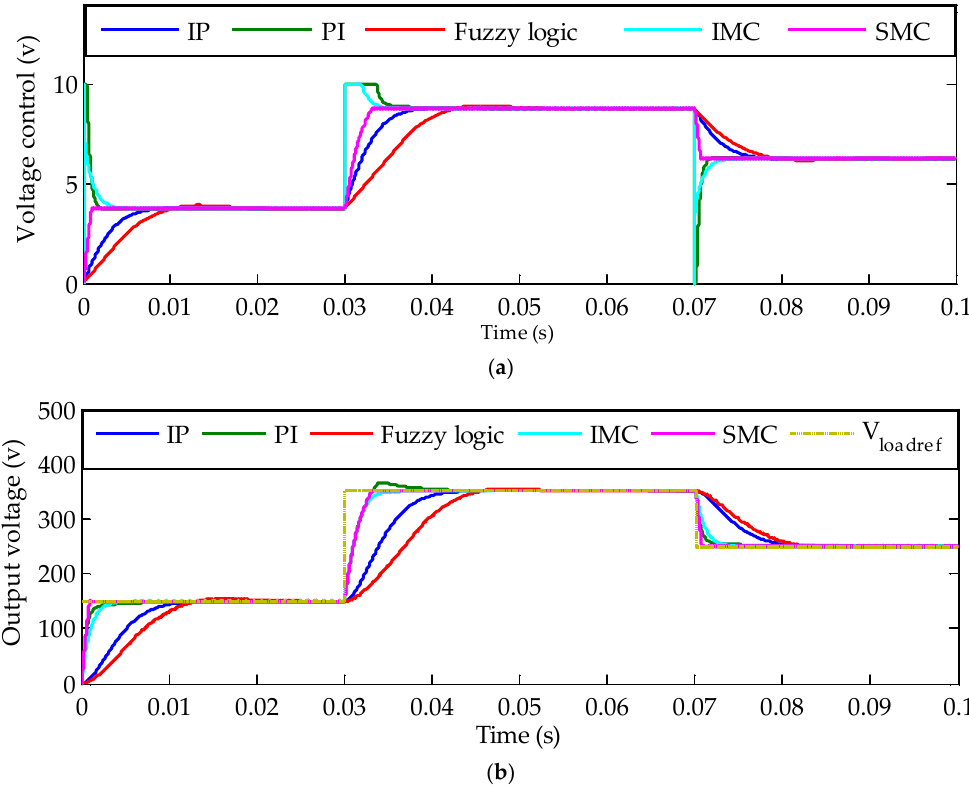
Figure 8. Target output voltage variation: ( a ) evolution of the control voltage and ( b ) evolution of the output voltages.